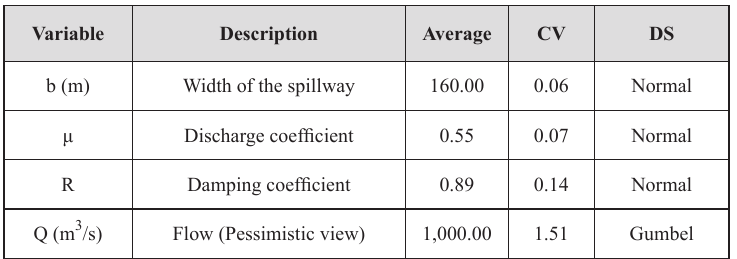
Data from studies of floods.